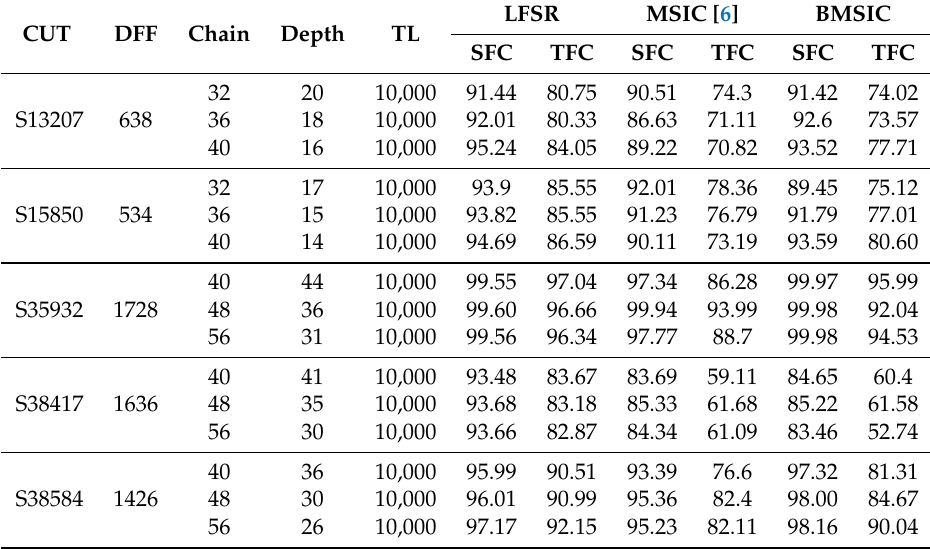
Table 2. Comparison of fault coverage of the three test generation